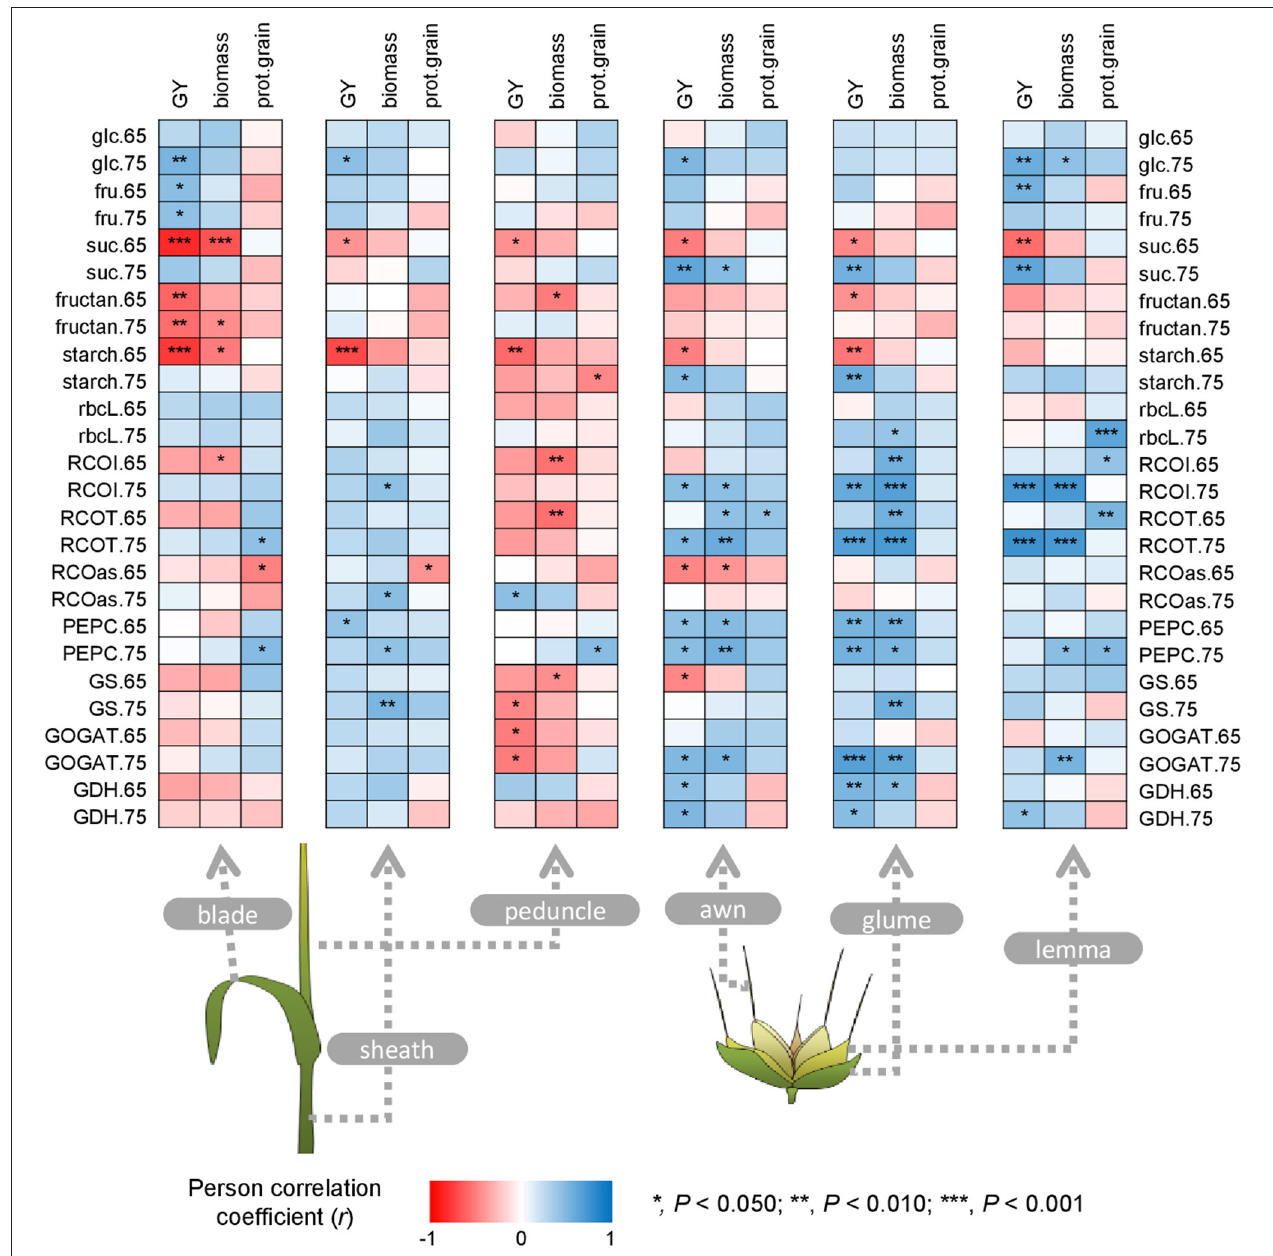
FIGURE 8 | Correlations between metabolic traits in the different green organs at anthesis (Zadoks 65) and mid-grain filling (Zadoks 75) and agronomic components and grain quality traits at harvest. Each point is a Pearson correlation coefficient between two traits (blue, positive correlation; red, negative correlation). Asterisks indicate a significant correlation according to the legend. The abbreviations are described in Supplementary Table 1